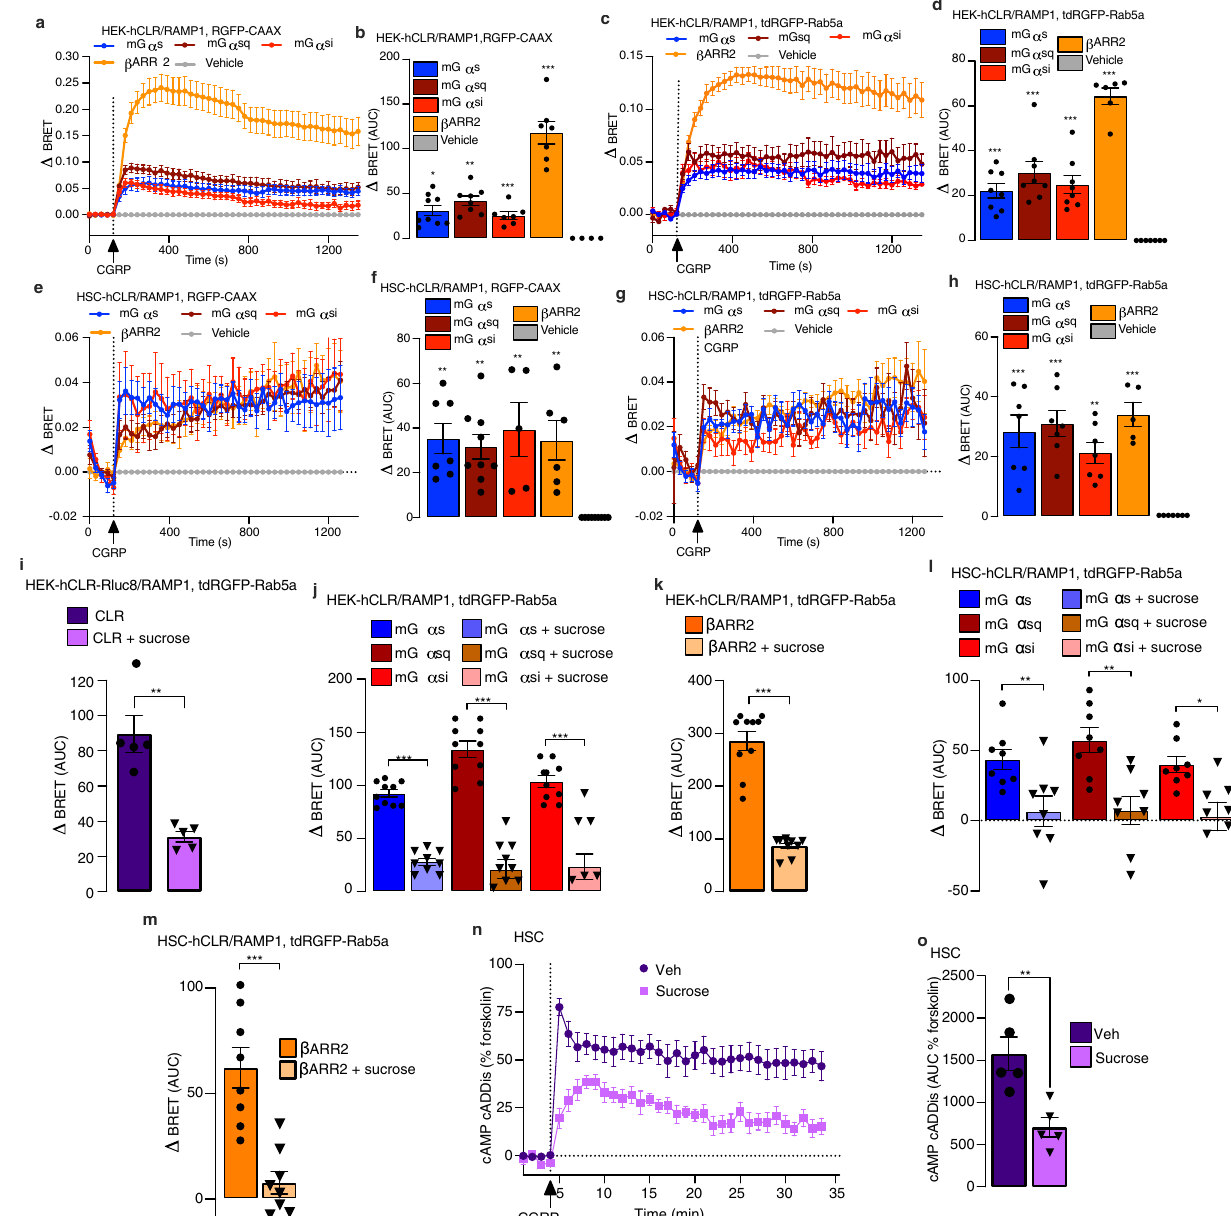
Fig. 5 CGRP leads to G α protein activation and β ARR2 recruitment at the plasma membrane and in early endosomes in HEK-hCLR/RAMP1 cells and HSCs-hCLR/RAMP1. Endosomal signaling generates sustained formation of cAMP in HSCs. ( a – d ) CGRP (100 nM) increased EbBRET between Rluc8- mG α s , Rluc8-mG α sq , Rluc8-mG α si , and Rluc2- β ARR2 with RGFP-CAAX ( a , b ) and tdRGFP-Rab5a ( c , d ) in HEK-hCLR/RAMP1 cells. a , c time course. b , d area under curve (AUC) ( a , b n = 10 mG α s , n = 8 mG α sq, n = 7 mG α si, n = 7 β ARR2, n = 9 veh; c , d n = 8 mG α s , n = 8 mG α sq, n = 8 mG α si, n = 6 β ARR2, n = 9 veh). e – h CGRP (100 nM) increased EbBRET between Rluc8-mG α α α β ARR2 with RGFP-CAAX ( e , f ) and s , Rluc8-mG sq , Rluc8-mG si , and Rluc2- tdRGFP-Rab5a ( g , h ) in HSC-hCLR/RAMP1 cells. e , g time course. f , h AUC ( e , f n = 7 mG α s , n = 9 mG α sq, n = 5 mG α si, n = 6 β ARR2, n = 9 veh; g , h n = 7 mG α s , n = 7 mG α sq, n = 7 mG α si, n = 5 β ARR2, n = 7 veh). ( i ) Hypertonic sucrose (0.45 M) inhibited CGRP (100 nM)-stimulated EbBRET between hCLR- Rluc8 and tdRGFP-Rab5a in HEK-hCLR/RAMP1 cells ( n = 5 independent experiments). ( j , k ) Hypertonic sucrose (0.45 M) inhibited CGRP (100 nM)- stimulated EbBRET between Rluc8-mG α s , Rluc8-mG α sq , Rluc8-mG α si and Rluc2- β ARR2 with tdRGFP-Rab5a in HEK-hCLR/RAMP1 cells ( j , k n = 10 independent experiments). ( l , m ) Sucrose (0.45 M) inhibited CGRP (100 nM)-stimulated EbBRET between Rluc8-mG α s , Rluc8-mG α sq , Rluc8-mG α si , and Rluc2- β ARR2 with tdRGFP-Rab5a in HSC-hCLR/RAMP1 cells. ( n = 8 independent experiments). ( n , o ) Sucrose (0.45 M) inhibited CGRP (100 nM)- stimulated formation of cAMP in HSCs. n time course. o, AUC ( n = 5 independent experiments). Mean±SEM.. * P < 0.05, ** P < 0.01, *** P < 0.001, vs. Veh. 1-way ANOVA, Dunnett ’ s correction ( b , d , f , h ) or parametric unpaired t test ( i – m , o ). Source data are provided as a Source Data fi